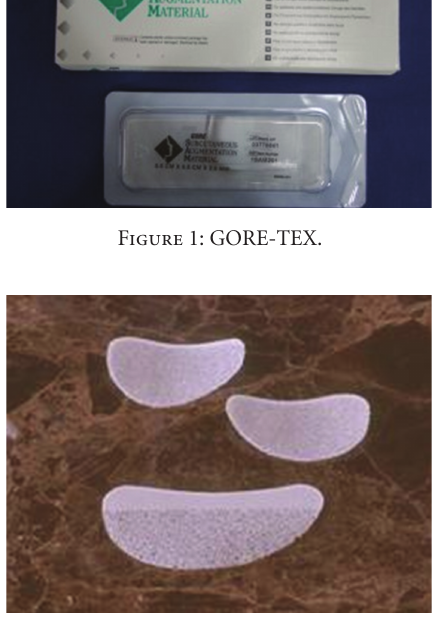
Figure 2: Porous high-density polyethylene